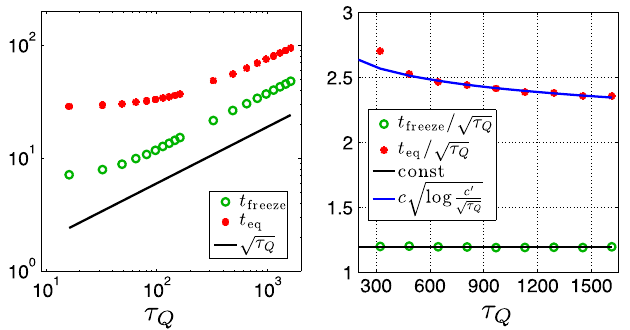
n τ for n ¼ 2 ; … ; 10 (from left to right) Q ¼ o the thermal quench is over. All curves experience a Q (2.19), which we operationally define as the time at which eq on a logarithmic scale for quench rates freeze curves corresponding to fast quenches collapse into a single one, Q (B15). c